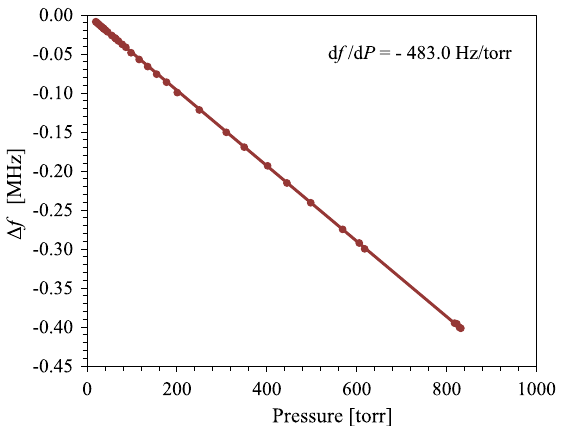
FIG. 16. Effective surface resistance during the cavity cool- down from 4.2 to 2.0 K.